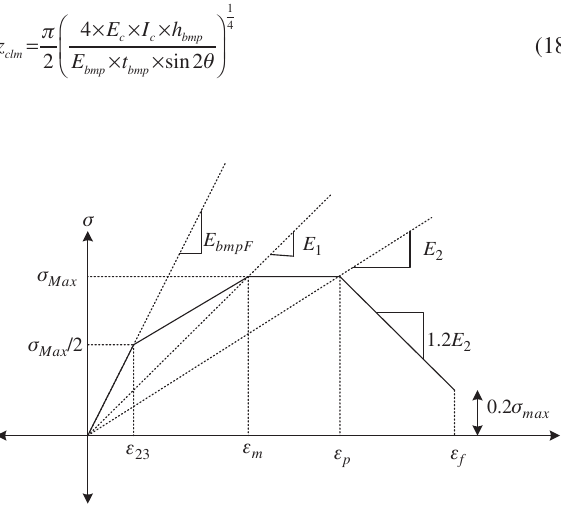
Figure 15 Damage state of specimen SA2.3-CCM at the end of loading scheme.